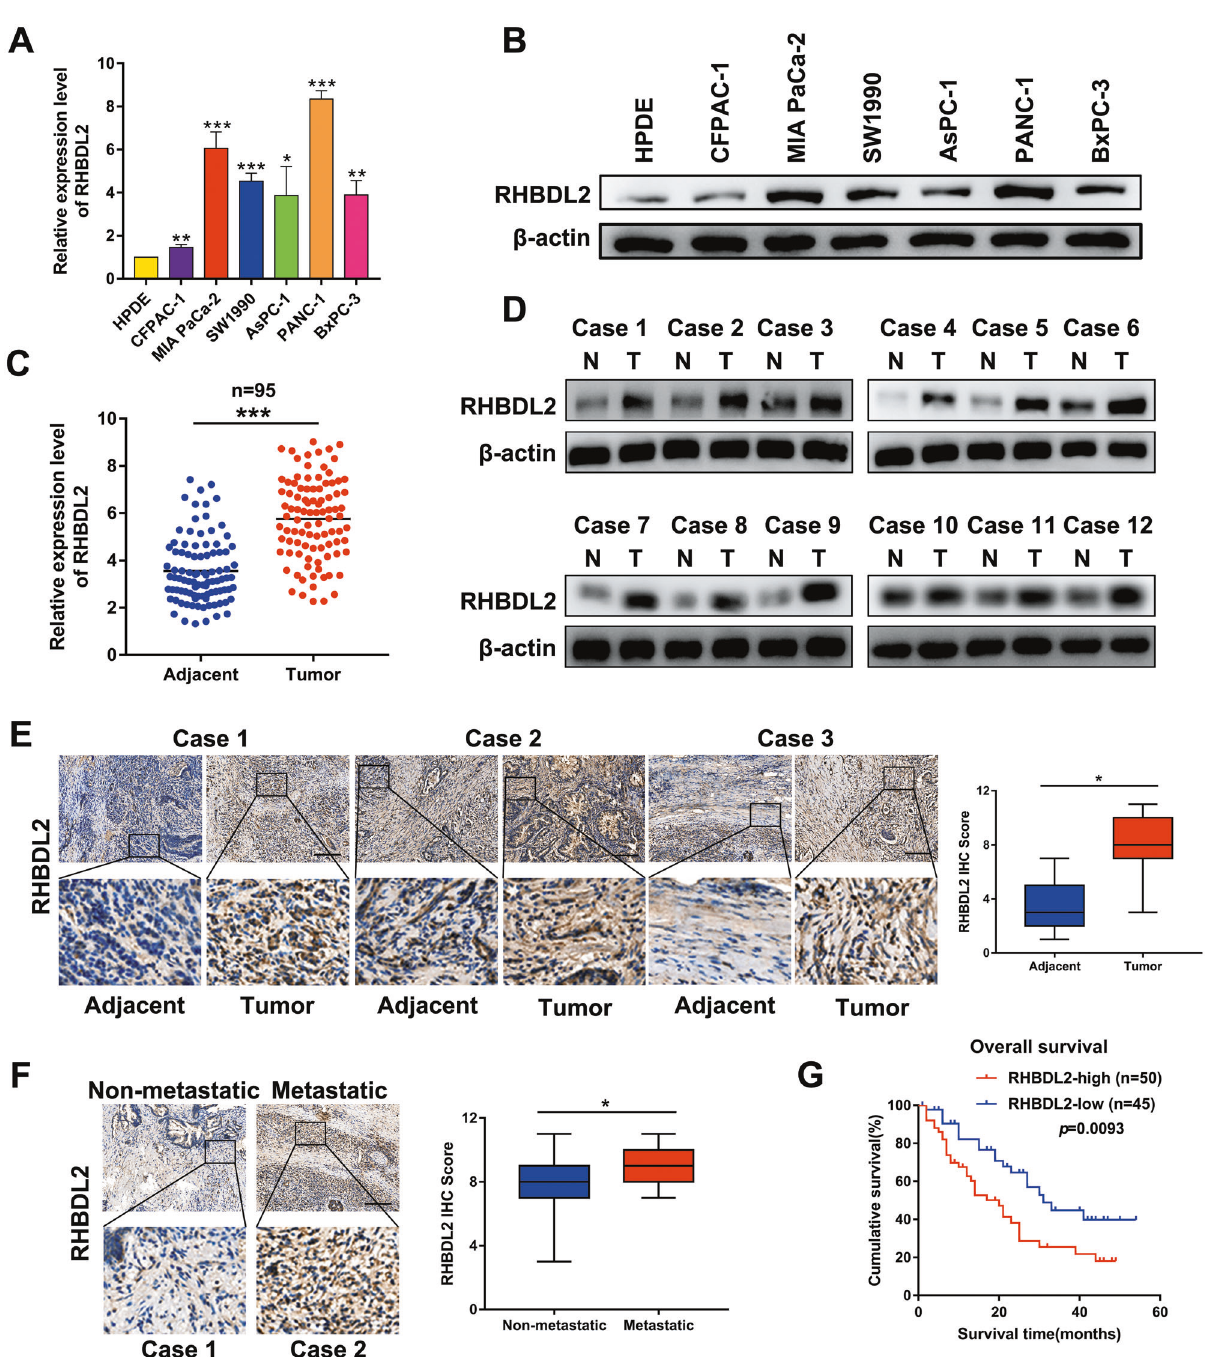
Fig. 1 RHBDL2 is upregulated in PC and positively related to worse prognosis of PC patients. A , B Expression of RHBDL2 in the HPDE cells and six PC cell lines (CFPAC-1, MIA PaCa-2, SW1990, AsPC-1, PANC-1, and BxPC-3) was determined by qRT-PCR and Western blot assays, respectively. C , D qRT-PCR and Western blot analysis of RHBDL2 expression in PC tissues and adjacent non-tumor tissues. IHC assay con fi rmed the levels of RHBDL2 expression in the PC tissues compared with that in the adjacent non-tumor tissues ( E ), and in metastatic PC tissues compared with that in non-metastatic PC tissues ( F ), respectively ( n = 95). Scale bar: 100 μ m. G Kaplan-Meier analysis of PC patients with high/ low RHBDL2 expression. * P < 0.05, ** P < 0.01, *** P < 0.001.